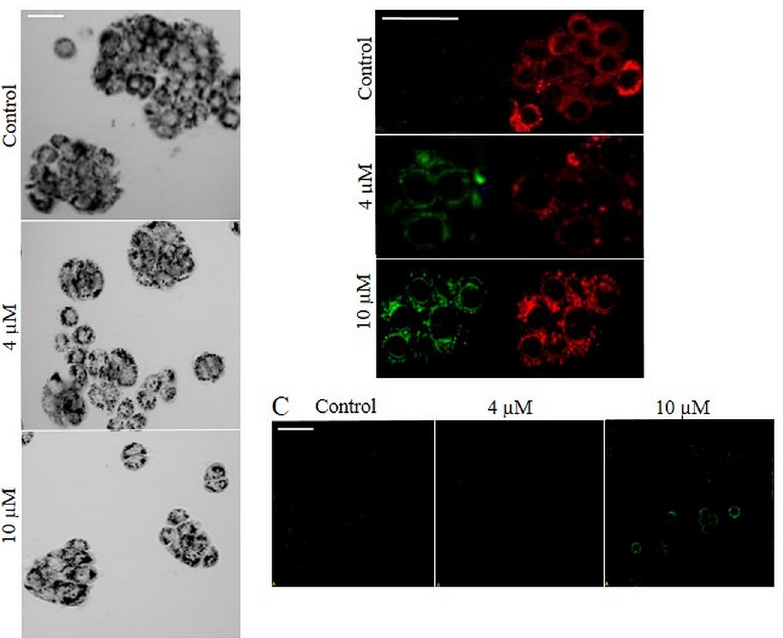
Fig 5. Effect of SFN on MTT reduction. (A) Microscope images of formazan crystals in HT-29 cells. Cells were incubated with 4 and 10 μ M of SFN for 24 h. Microscope images were recorded after 3 h of reduction of MTT. Black dots indicate formazan crystals. (B) Microscope images of SFN-induced changes in mitochondrial membrane potential ( ΔΨ m). HT-29 cells were incubated with 4 and 10 μ M SFN and stained with MitoLight dye, which stains mitochondria in a membrane potential-dependent fashion. Changes in the mitochondrial membrane potential ΔΨ m were detected by confocal microscopy. Left image presents the detection of the monomers (green fluorescence), indicating the presence of depolarized mitochondria). Right image presents fluorescence of the aggregates (red fluorescence), indicating functional, polarized mitochondria. (C) Microscope images of the intracellular reactive oxygen species induction (ROS) by SFN (green fluorescence). HT-29 cells were incubated with 4 and 10 μ M SFN for 24 h and stained with the ROS- sensitive dye DHR123. Scale bar = 50 μ